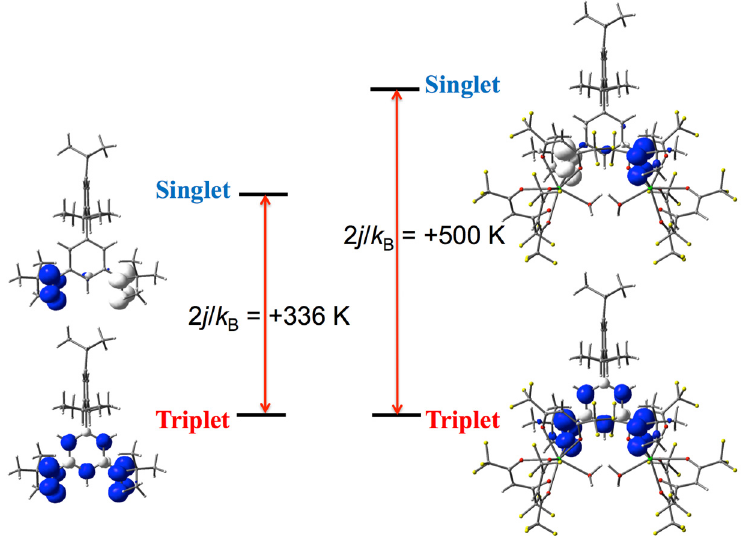
Figure 5. The relative energy levels of the triplet and singlet states for the uncoordinated ligand iPr 3 BPBN (left) and a model complex [{Y(hfac) 3 (H 2 O)} 2 ( μ - iPr 3 BPBN )] (right). DFT calculation was performed on the geometries from the crystallography. Spin density surfaces are drawn at the 0.004 e - Å − 3 level with dark and light lobes for the positive and negative spin densities, respectively. For the atomic color code, see Figure 3. iPr 3 BPBN : The self-consistent field (SCF) energies are − 1391.20031758 au with < S 2 > = 2.0002 and -1391.19929024 au with < S 2 > = 0.0708 for the triplet and singlet states, respectively. [{Y(hfac) 3 (H 2 O)} 2 ( μ - iPr 3 BPBN )]: The SCF energies are -7265.92989889 au with < S 2 > = 2.0003 and − 7265.92837108 au with < S 2 > = 0.0727 for the triplet and singlet states, respectively. For details, see Figures S6 and S7, Tables S2 and S3, Supporting